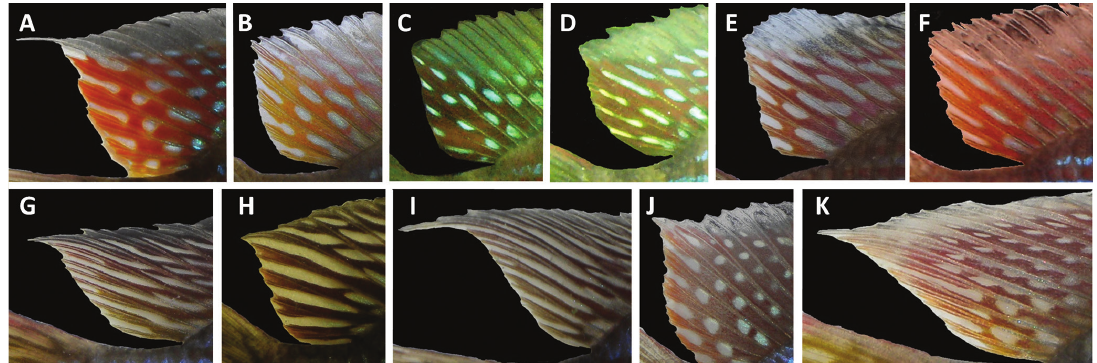
Fig. 3 . Soft dorsal fin pigmentation patterns: (A-F) Gymnogeophagus terrapurpura , (G-I) G. rhabdotus , (J-K) G. meridionalis .